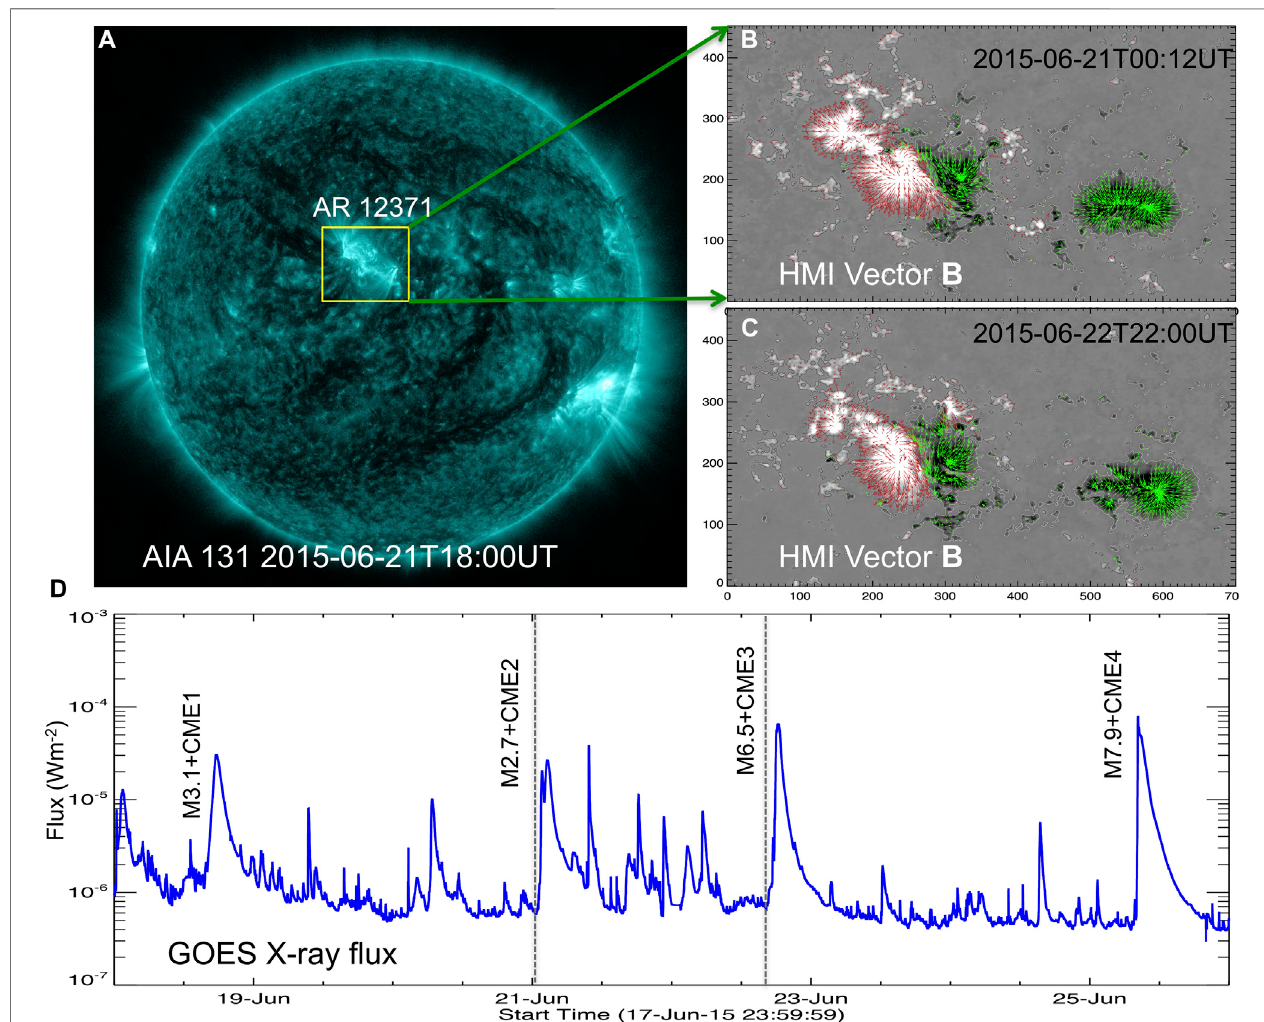
FIGURE 3 | Observations of the successively erupting AR 12371 (A) Full disk observation of AIA 131 Å. The structured emission from AR 12371 is outlined with yellow rectangular box, (B-C) HMI vector magnetogram observations of the AR 12371 at the onset of CME eruptions on June 21 and 22 respectively. The background image is vertical magnetic fi eld with contours at ± 120 G. Green/red arrows denote horizontal fi eld vector whose length is proportional to magnitude B h (cid:1) Axis units are pixels of 0.5 arc-second units, (D) Disk integrated GOES X-ray fl ux in 1 – 8 Å band during the disk transit time of the AR 12371. Text near the X-ray peaks refers to the CMEs and associated M-class fl ares from the AR 12371. The events marked with vertical lines are studied in this work.